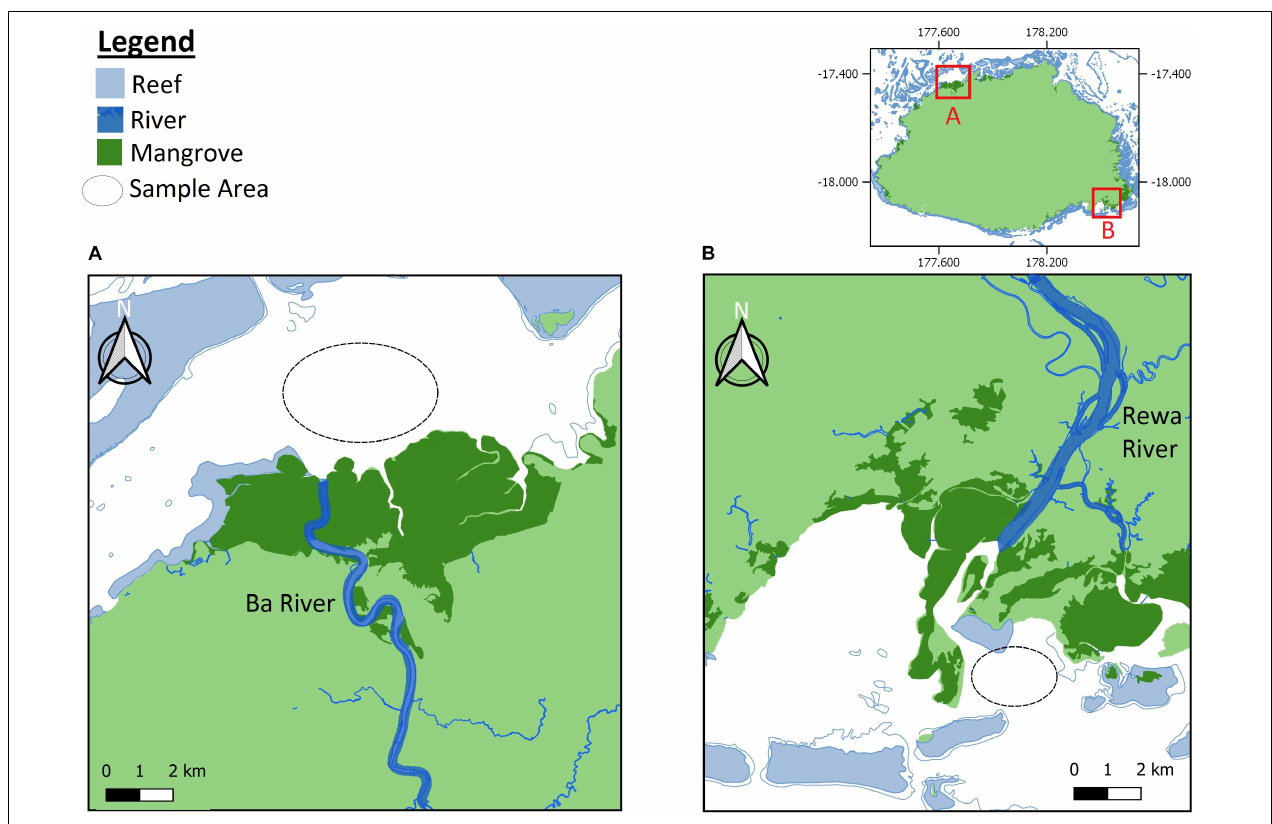
FIGURE 1 | Geographic location of sampling sites in Viti Levu Island, Republic of Fiji. This figure was prepared using online resources from QGIS, version 3.6.0